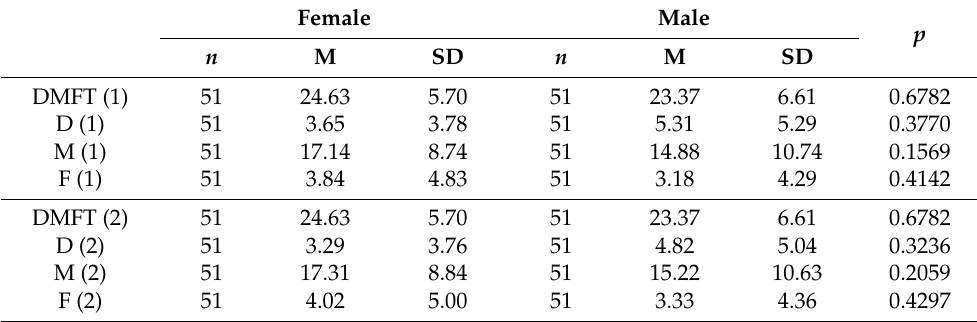
Table 13. Patients’ gender and DMFT index before (1) and after (2)